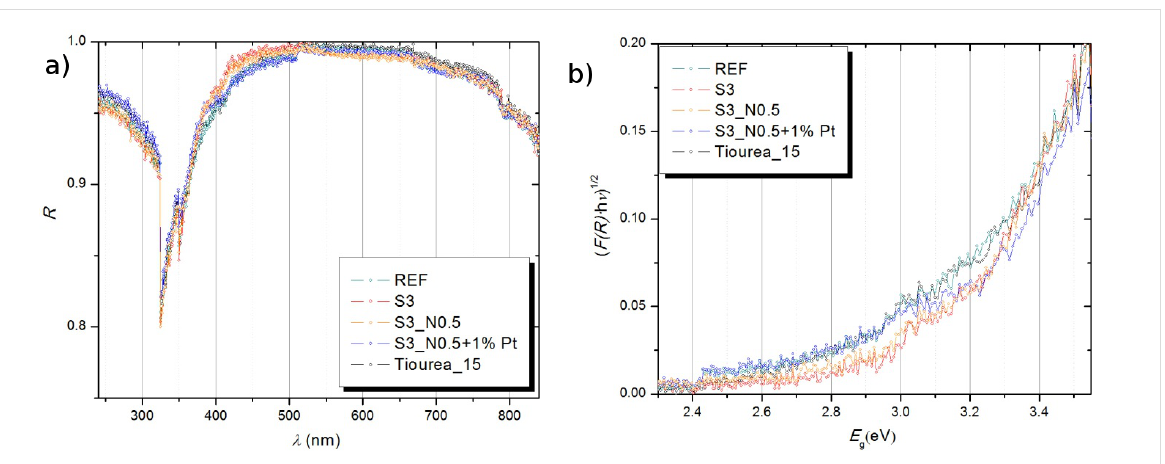
F ( R ) = (1 − R ) 2 / 2 R . The band gap energy was determined from this plot by extrapolating the linear fit of the straight section to the ( F ( R ) h ν ) n = 0 intercept of the energy